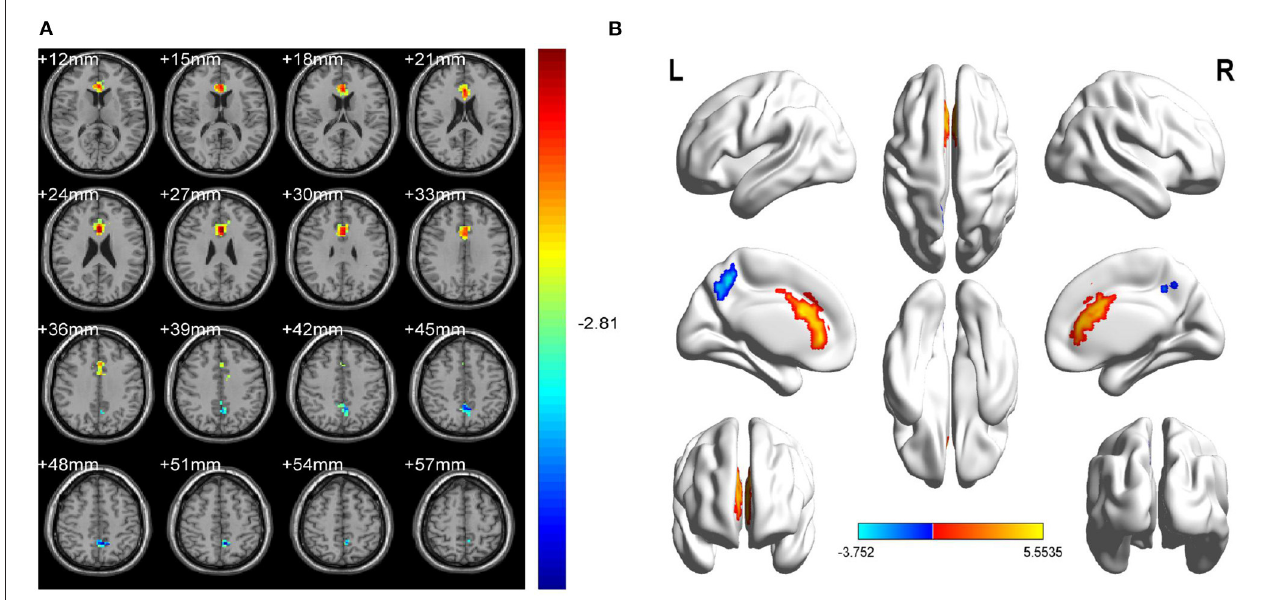
FIGURE 2 | Spontaneous brain activity in OH vs. HC. (A) Different fALFF values between the OH and HC groups. (B) Differences of brain activity in the cerebrum. Compared with HC, red represents the brain areas with increased fALFF, and blue represents the brain areas with decreased fALFF in OH patients. Multiple comparisons were corrected using Gaussian Random Field (GFR) theory (two-tailed, voxel-level P < 0.01, cluster-level P < 0.05). fALFF, fractional amplitude of low-frequency fluctuations; ALFF, amplitude of low-frequency fluctuation; OH, ocular hypertension; HC, healthy control; R, right; L, left.